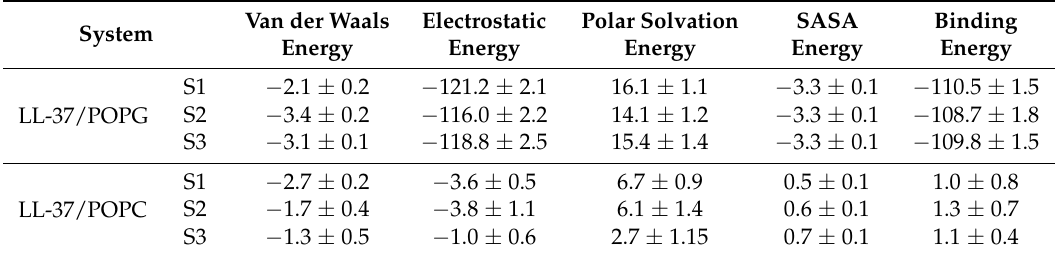
Table 1. The average binding free energy and its components of LL-37/POPG and LL-37/POPC